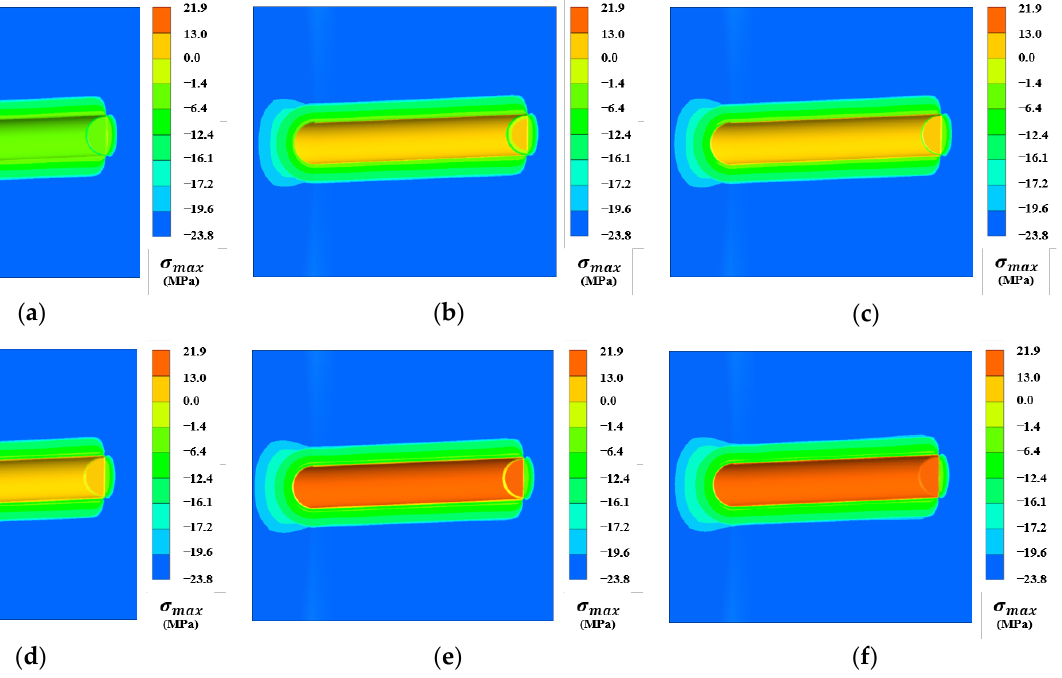
Figure 9. Magnitude and distribution of the maximum principal stress at t = 0~24 h in the tunnel. ( a ) t = 0 h; ( b ) t = 1 h; ( c ) t = 3 h; ( d ) t = 6 h; ( e ) t = 12 h; ( f ) t = 24 h. 5c. The length of the arrow is 5 m, the starting point of the arrow represents the 0 m position point of the horizontal axis of the coordinate, and the ending point represents the 5 m position t = 0~24 h. Figure 10a shows the trend of the maximum principal stress in Path 1 after cooling.